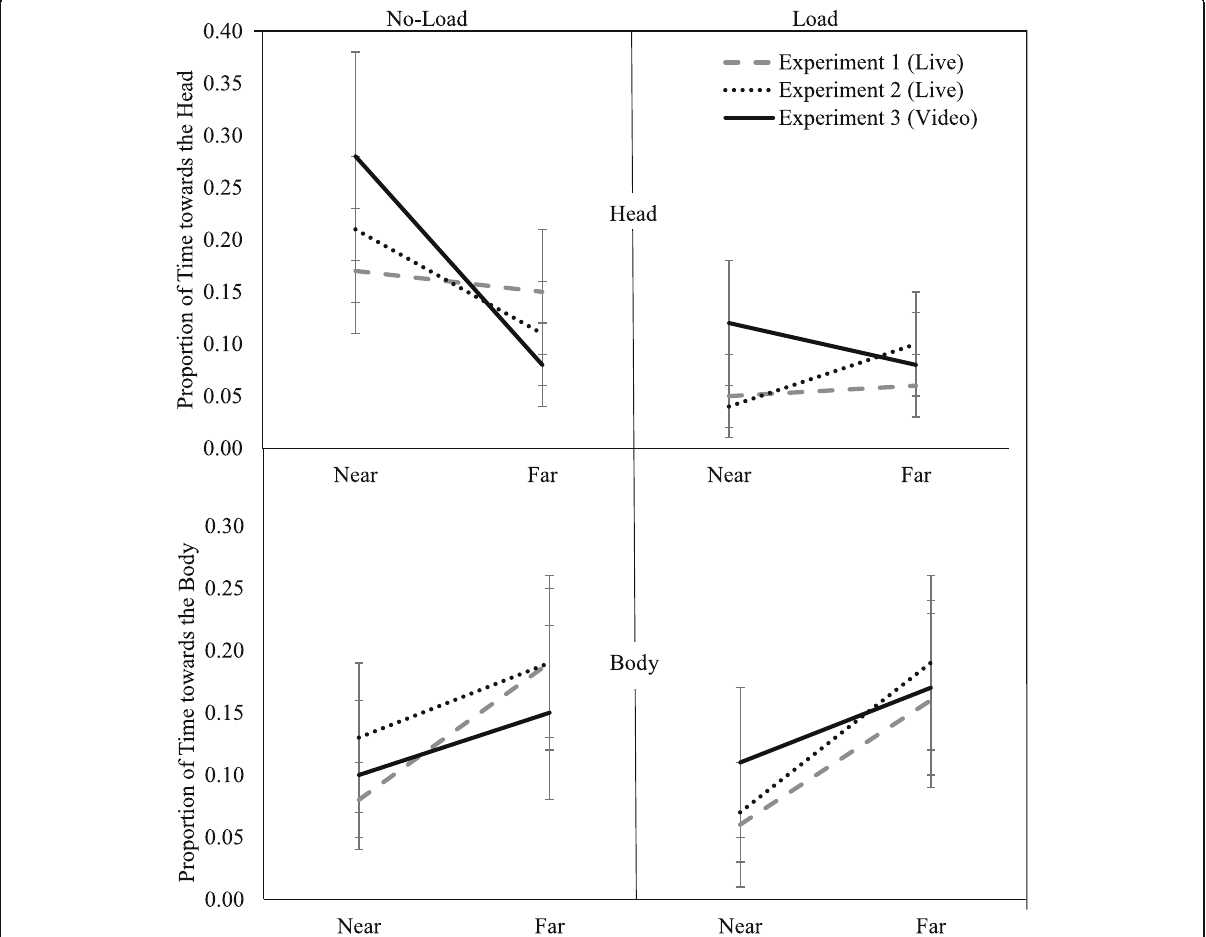
Fig. 7 The mean time spent on the confederate when the confederate was in view as a function of load (no load, load), location (head, body), and Experiment (Experiment 1, 2, 3). Bars represent 95% confidence